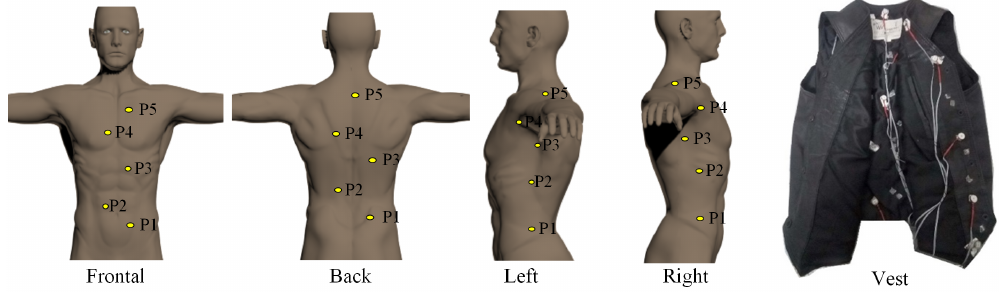
Figure 2. The arrangement of distribution of tactors around the torso and prototype of hlthe designed vibrotactile vest. In frontal of body, five tactors are located on the lower abdomen, upper abdomen, slightly below the chest, middle of chest and below of the clavicle respectively. In back of body, five tactors are located on the hip above, central spine, right shoulder, left shoulder, and cervical spine respectively. In the left or right side of body, five tactors, from down to up, are located on hipbone above, rib, oxter, chest and shoulder